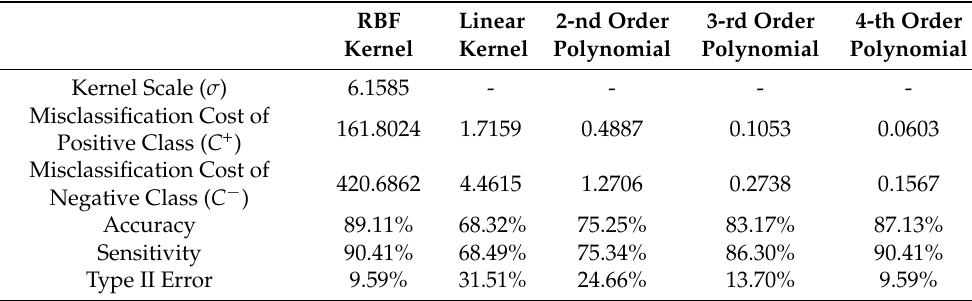
Figure 11. Confusion matrices of SVM classifiers with ( a ) the radial basis function (RBF) kernel, ( b ) the linear kernel, ( c ) the second-order polynomial kernel, ( d ) the third-order polynomial kernel, and ( e ) the fourth-order polynomial kernel. Table 2. Experimental results of each classifier.